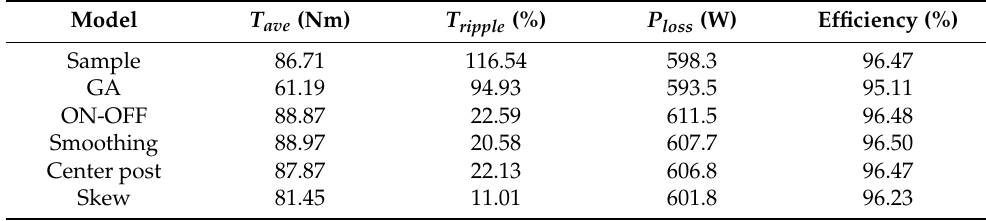
Table 4. Performance comparison for each optimization